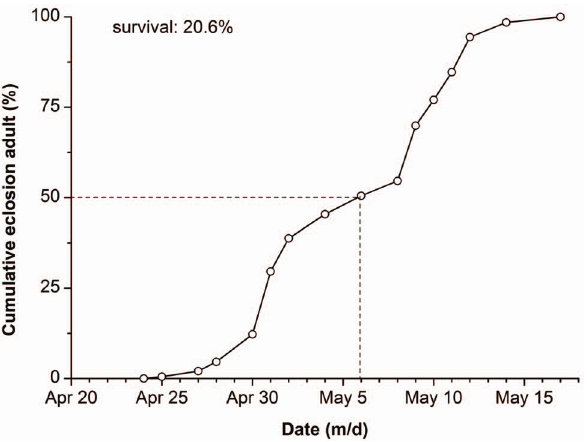
Figure 7. Cumulative rate of diapause termination in naturally overwintering pupae of H.cunea in spring of 2012 in Nanchang